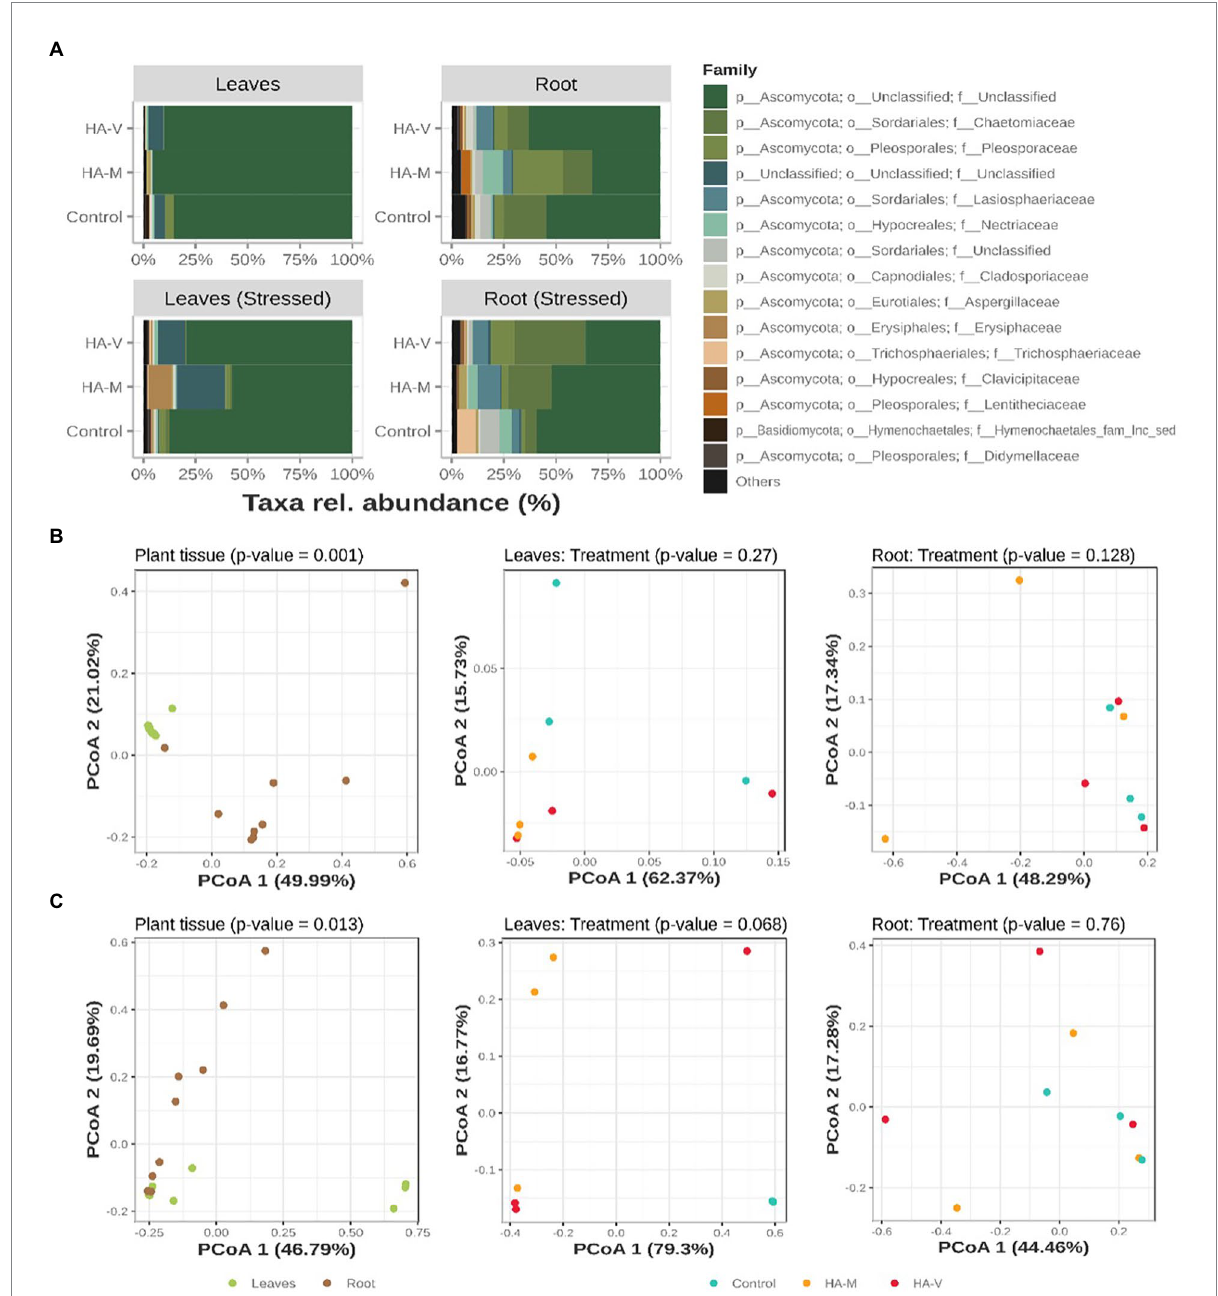
FIGURE 3 Relative abundances of the top 15 fungal ASVs, collapsed to the taxonomic level of “family” (A) . Graphic representation of principal coordinate analysis (PCoA) based on the Bray–Curtis distances of samples in the absence (B) and presence (C) of stress. At the first level (on the left), the PCoAs of all samples are observed and tested in terms of separation by plant material. Next (center and right), the distribution of leaf and root samples, respectively, tested according to the treatments received is observed. Treatments refer to the application of vermicompost HA (HA-V) and millicompost HA (HA-M) and that did not receive application